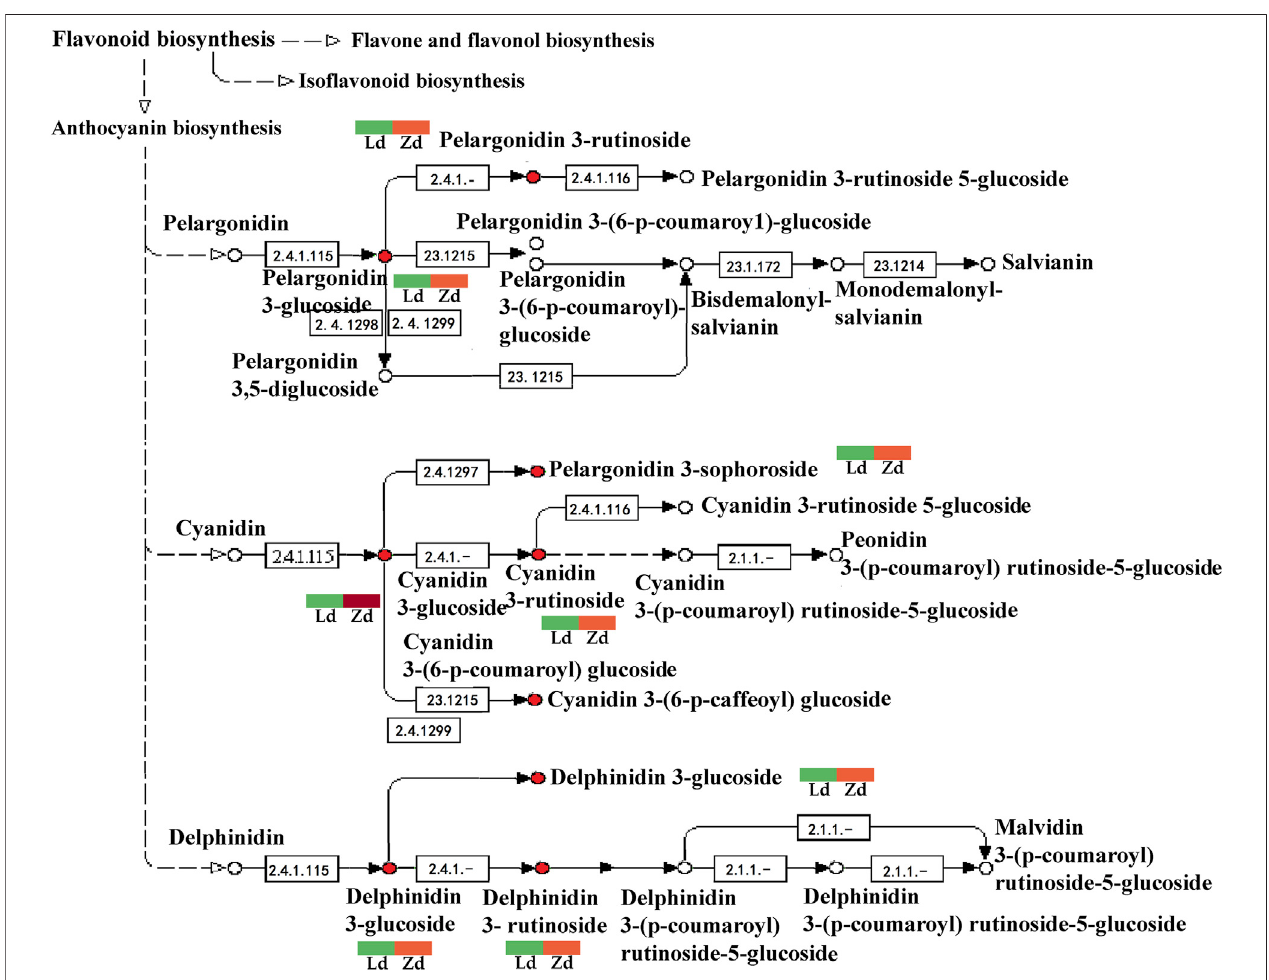
FIGURE 9 | Detailed analysis of anthocyanin biosynthesis pathways based on metabolome data from peel samples from the apex (Ld and Zd) of L and Z line eggplant fruits, respectively. Green means down-regulated, red means up-regulated.